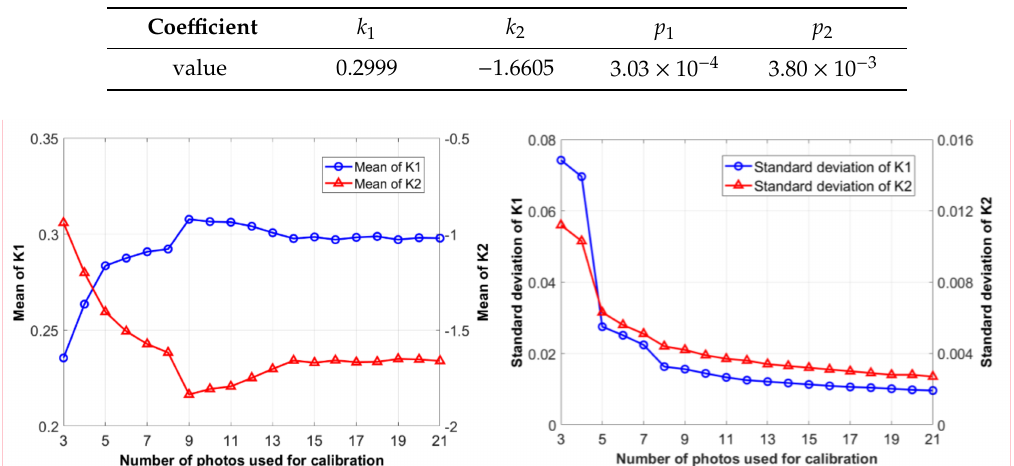
Table 2. Distortion coe ffi cients of iPhone 7 back camera.